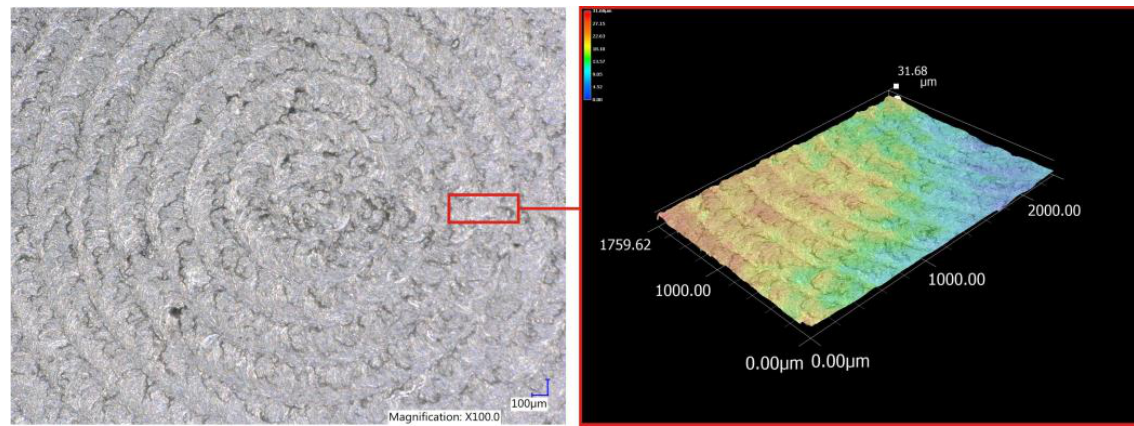
Figure 25. Display of surface texture and SH in circular pocket strategy.